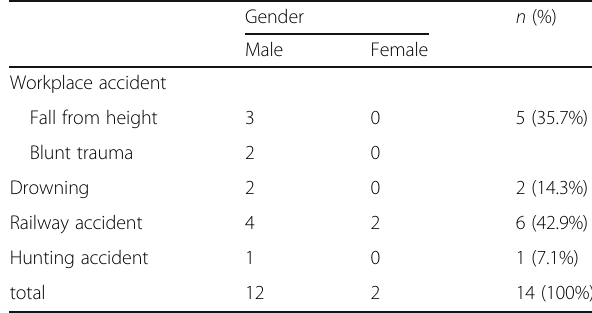
Table 6 Epidemiological data of accidental deaths other